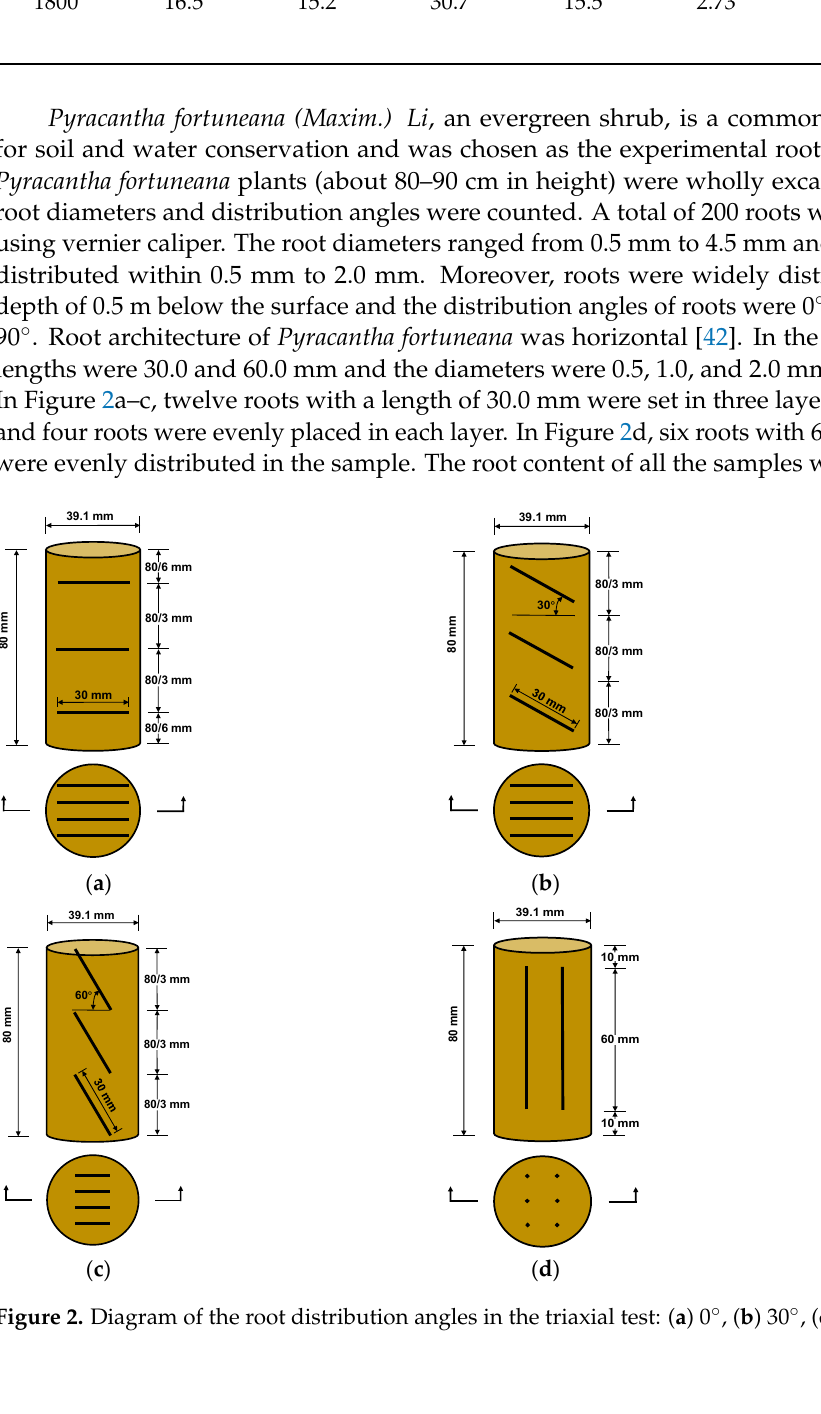
Table 2. Physical properties of the tested soils.